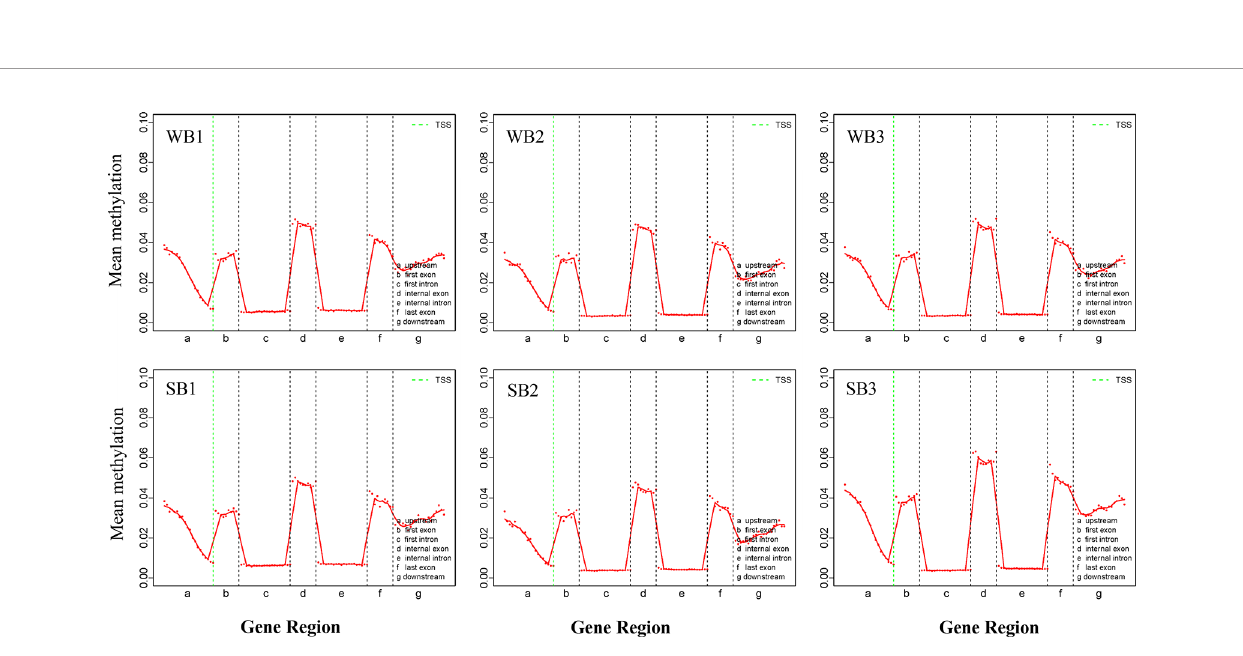
FIGURE 3 | The trend of mCG type distribution across different functional regions. WB, Winter Bee; SB, Spring Bee. The abscissa represents the different regions of gene functional elements. The dotted green line denotes the transcriptional start site. The ordinate represents the methylation levels of